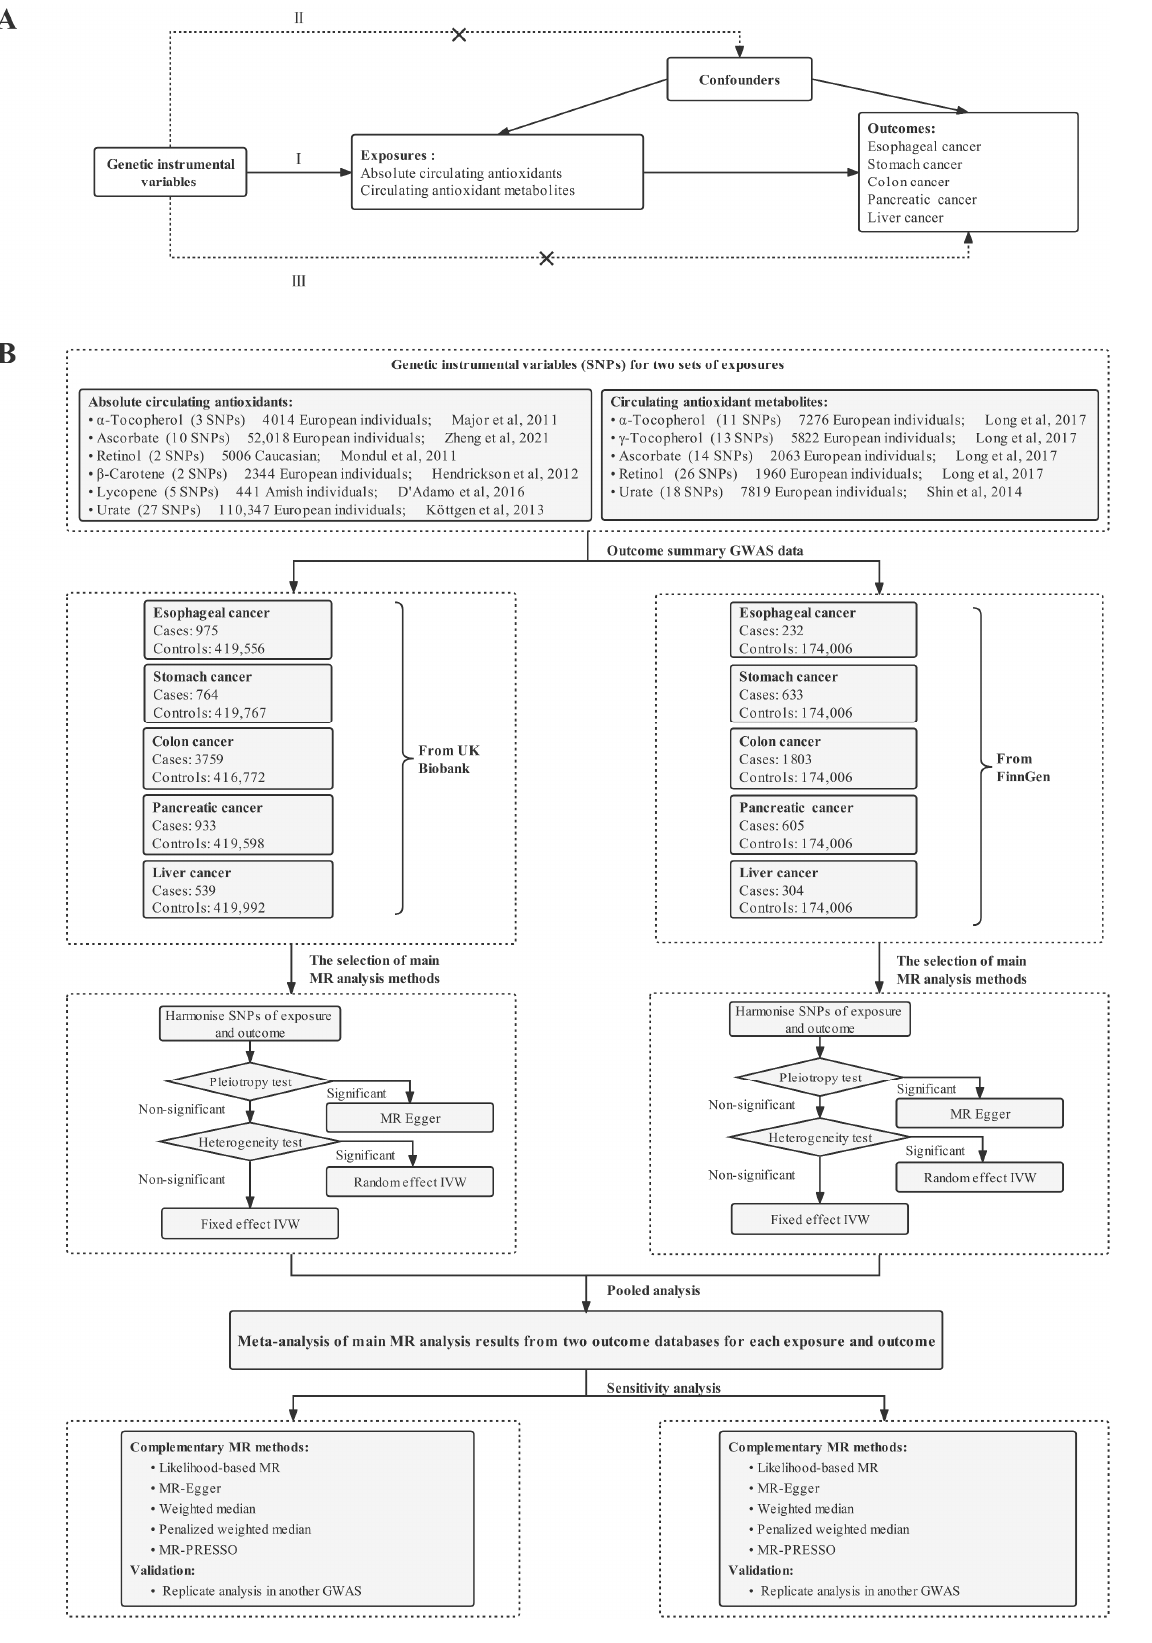
Figure 1. Schematic overview of the MR study design. ( A ) Principles of this MR study. There